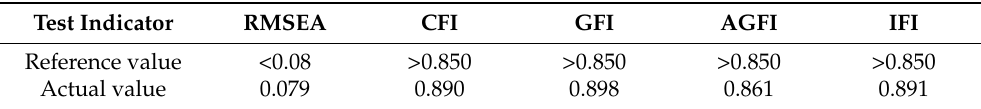
Table 5. Test for goodness of